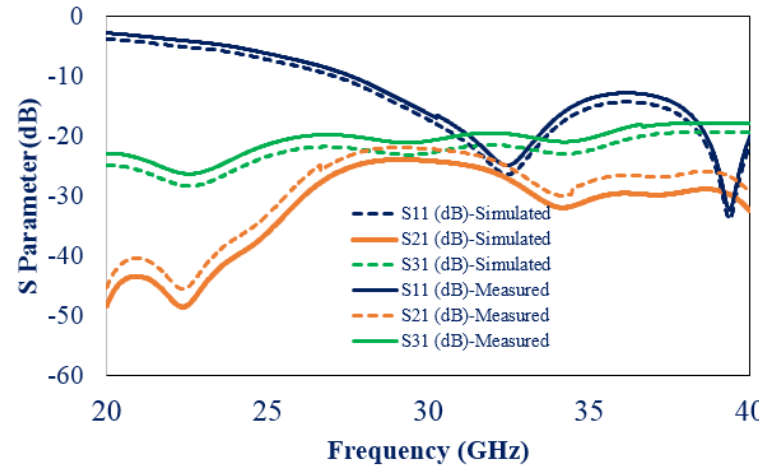
Figure 14. Measured S parameter result of three-element antenna (case 1).